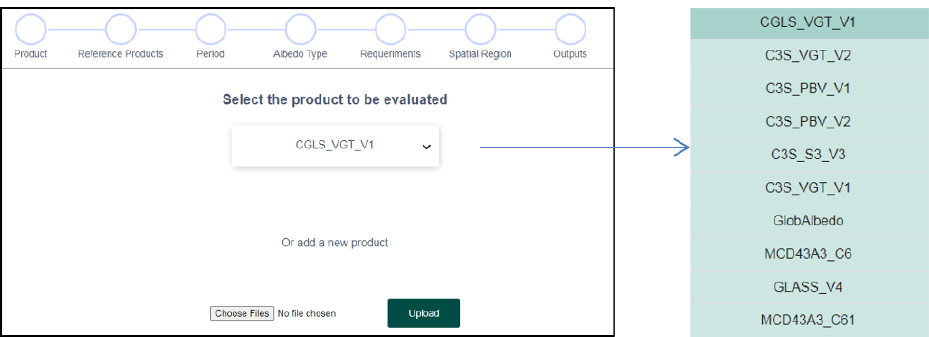
Figure A2. Snapshot of SALVAL configuration step 2. (3) Define the input product: time period, albedo type, requirements, and spatial cov- erage.